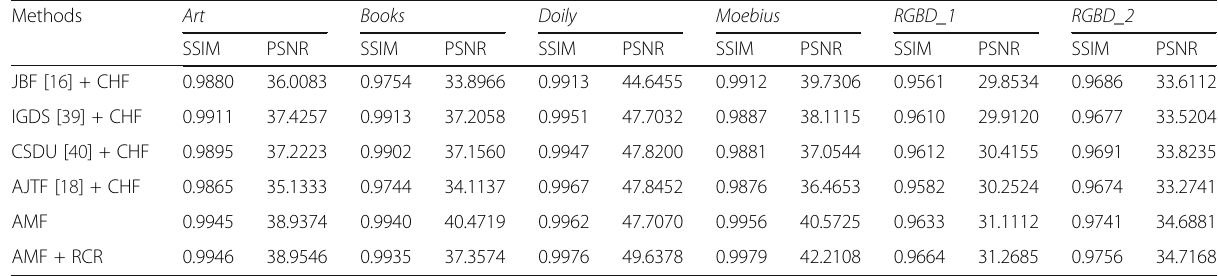
Table 7 SSIM and PSNR performance achieved by different depth enhancement methods on Middlebury dataset and RGBD dataset